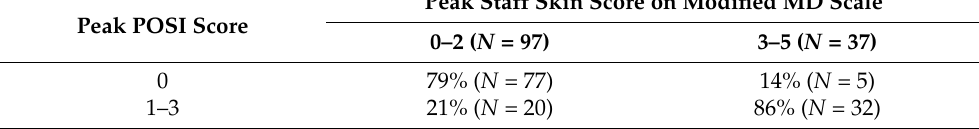
Table 4. Sensitivity and specificity of POSI open skin to reflect staff assessment of MD. The POSI questionnaire is scored from 0 to 3, with 0 meaning no MD and scores from 1 to 3 indicating some extent of MD.